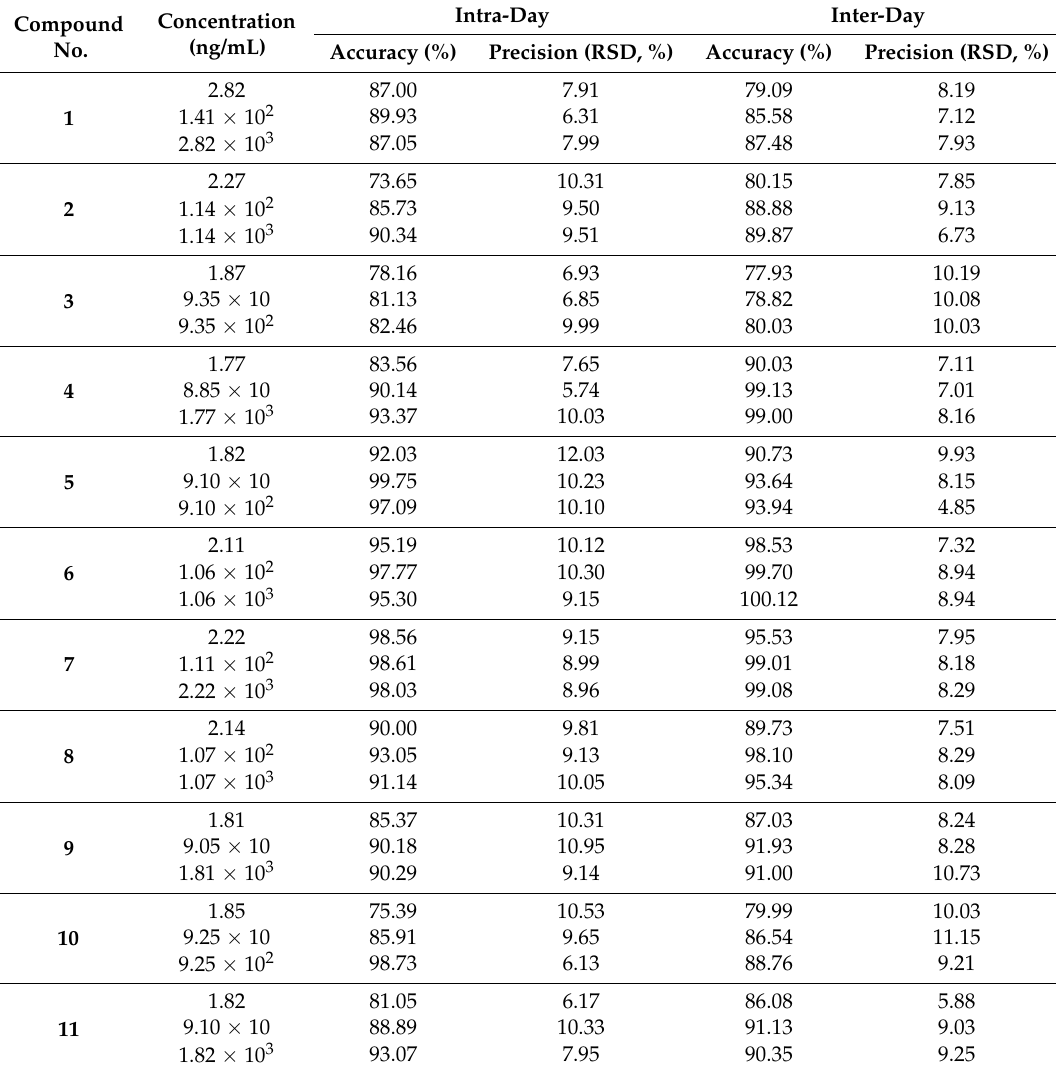
Table 3. Precision and accuracy of determination of the four compounds in rat plasma.